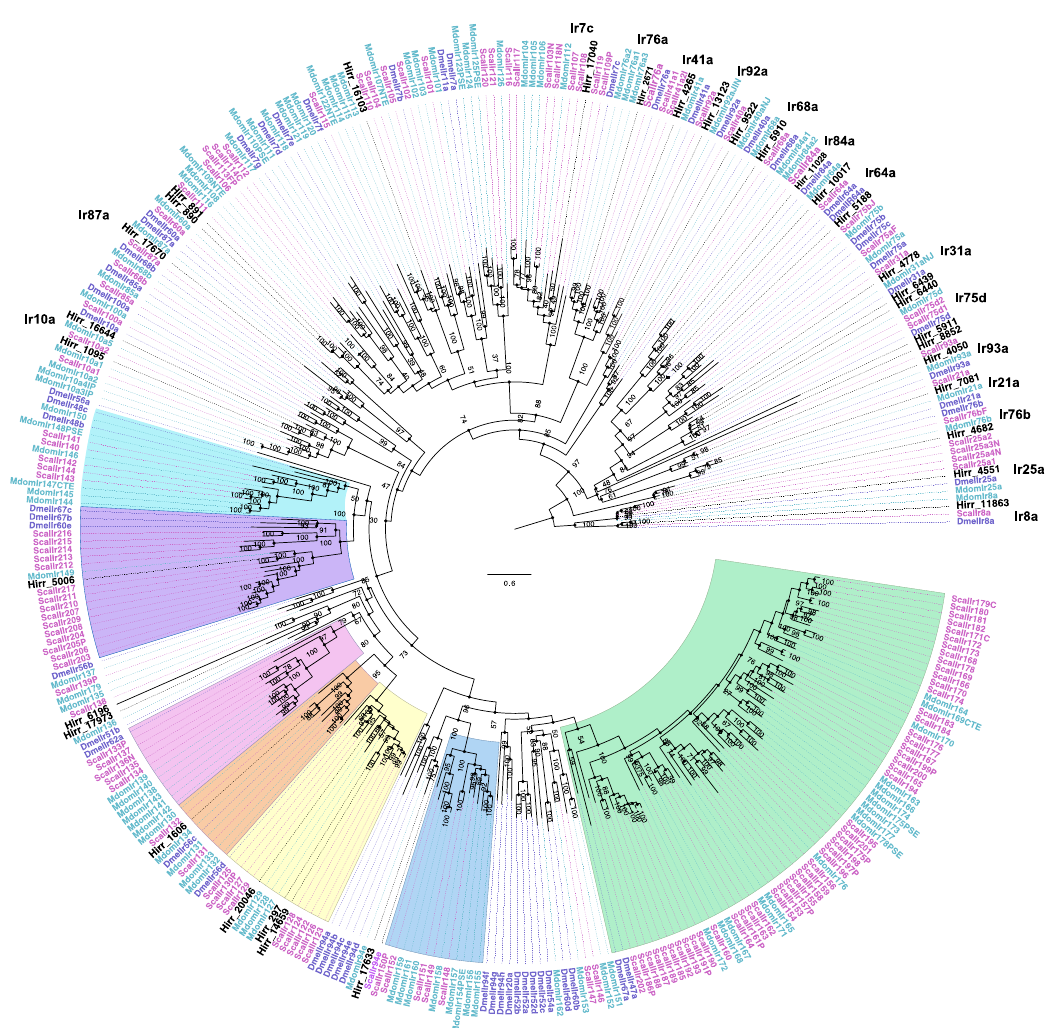
Figure 10. Phylogenetic relationship of Haematobia irritans candidate ionotropic receptors (IR) with those of Stomoxys calcitrans , Musca domestica, and Drosophila melanogaster . The H. irritans (Hirr) genes are labeled in black, while the S. calcitrans (Scal) and M. domestica (Mdom) genes are labeled in pink and teal, respectively. D. melanogaster (Dmel) genes are labeled in purple. Shaded regions identify genes in the Ir20a clade that are expanded in S. calcitrans and M. domestica , as described in [44]. Color pattern of clades used in [44] is reflected here. Individual Drosophila genes are labeled on the edge to assist with finding them in the